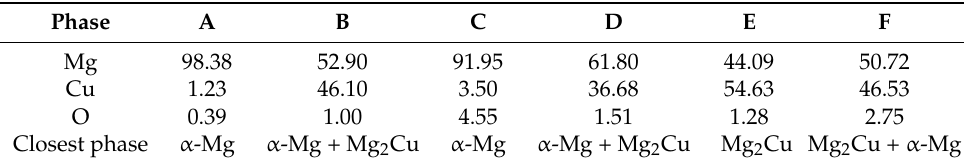
Table 2. Chemical composition of intermetallic phases in Figure 2 (in wt.%).